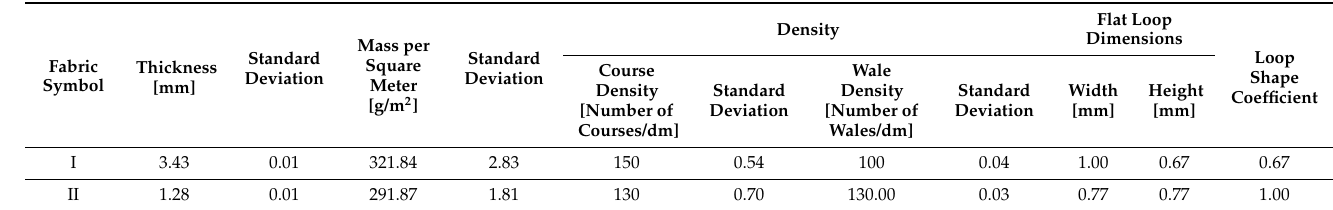
Table 2. The characteristics of the knitted fabrics.